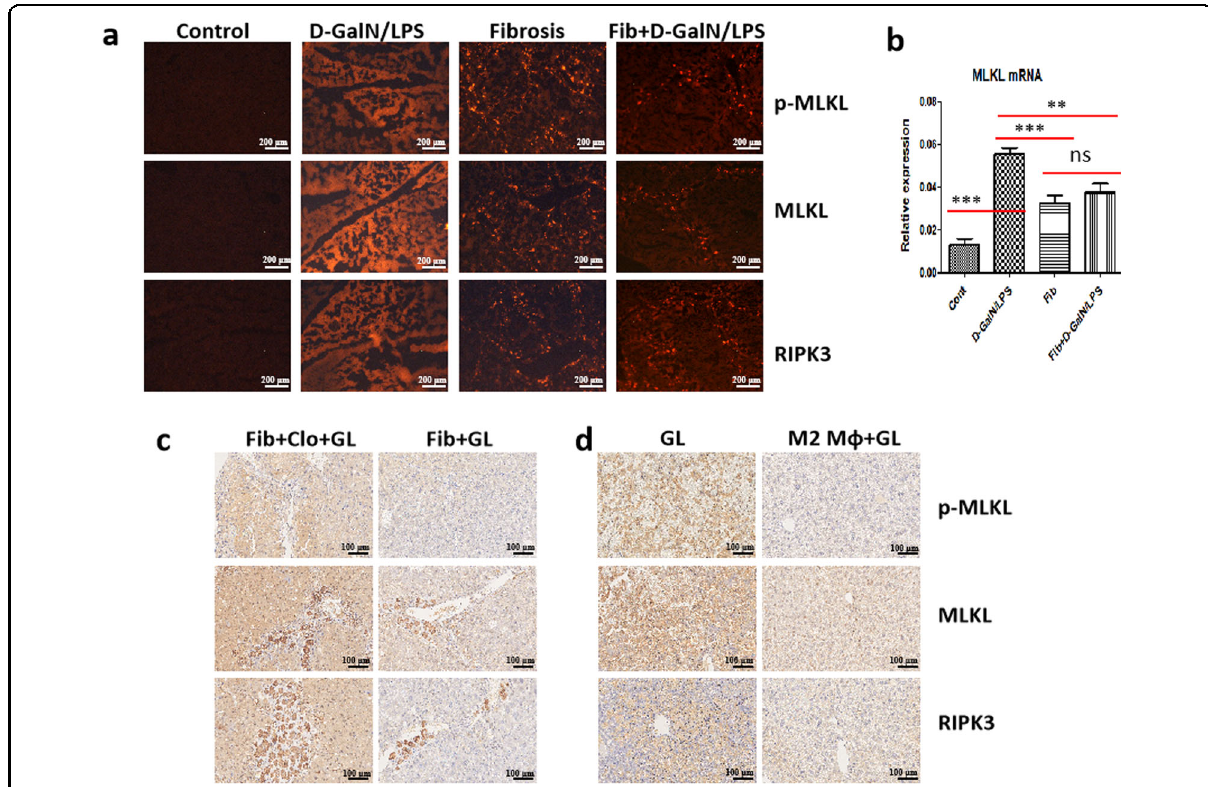
Fig. 2 Fibrosis inhibits necroptosis signaling triggered by D-GalN/LPS, which can be attributed to M2-like macrophages. a The expression of necroptosis markers including RIPK3, MLKL, and P-MLKL in control and fi brotic mice with or without D-GalN/LPS challenge. b The mRNA levels of necroptosis marker MLKL in control and fi brotic mice with or without D-GalN/LPS challenge. ( n = 5 – 7). c Comparison of the expression of necroptosis markers including RIPK3, MLKL, and P-MLKL in fi brotic mice upon acute insult with or without M2-like macrophage depletion (Clo: Liposome- encapsulated clodronate). d Comparison of the expression of necroptosis markers including RIPK3, MLKL, and P-MLKL in control mice upon acute insult with or without M2-like macrophage transfer. GL